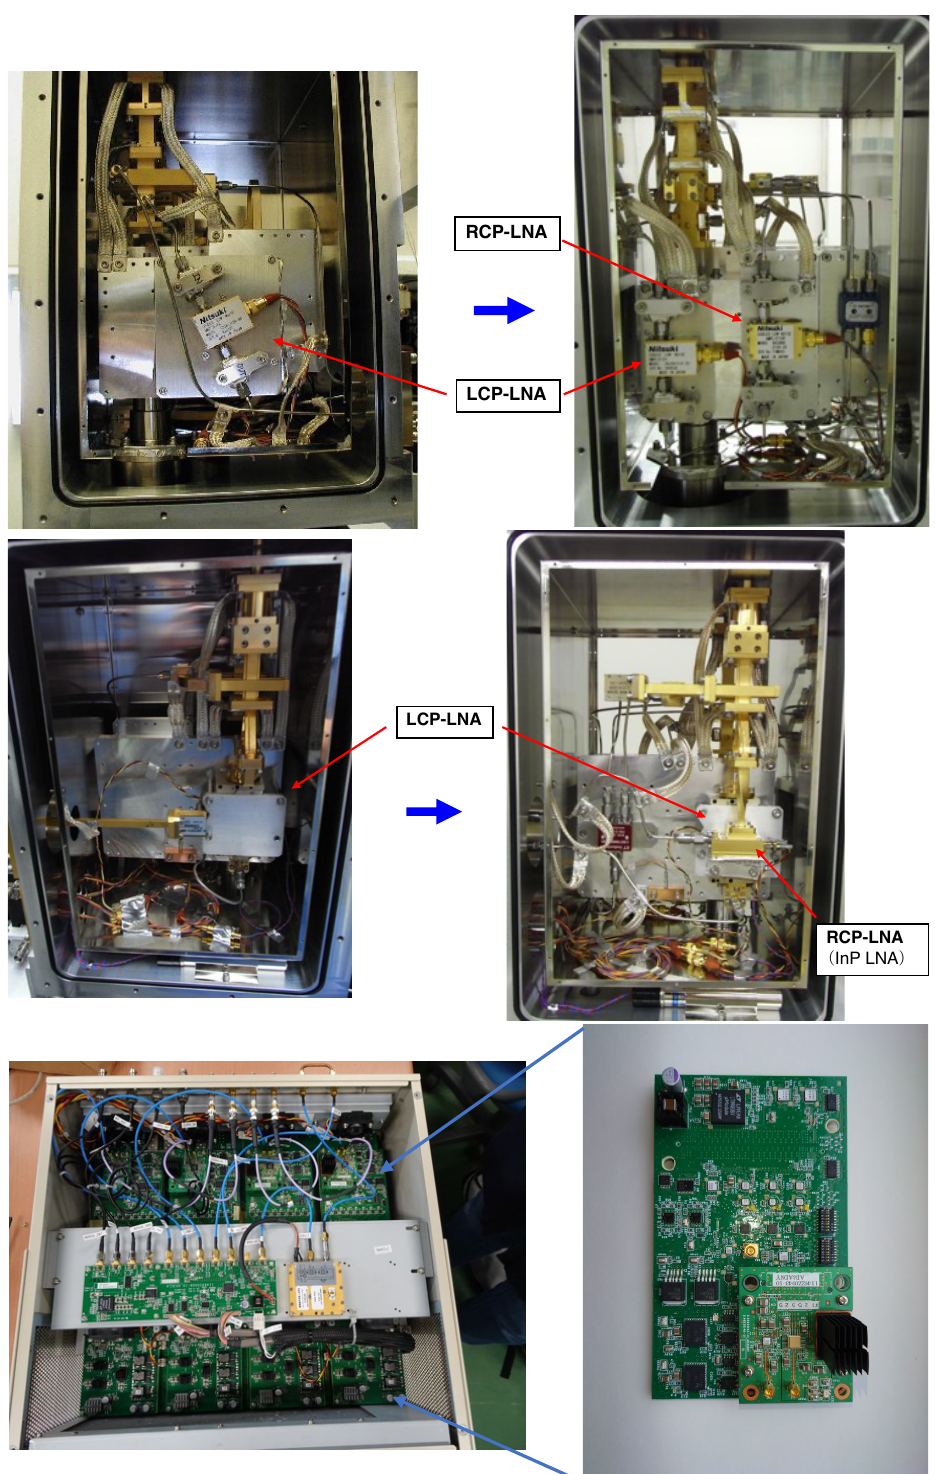
Figure 3. Interiors of the cryogenic dewars with the single-polarization (LCP) 22 GHz ( top left) and 43 GHz band ( middle left ) receivers, before 2018. Interiors of the dewars with the new dual-circular polarization at 22 GHz ( top right) and 43 GHz ( middle right) band receivers (photos by Japan Communication Equipment Co., Ltd.). (Bottom left) : an interior of OCTAD and (bottom right) : an OCTAD channel board mounted on an FPGA